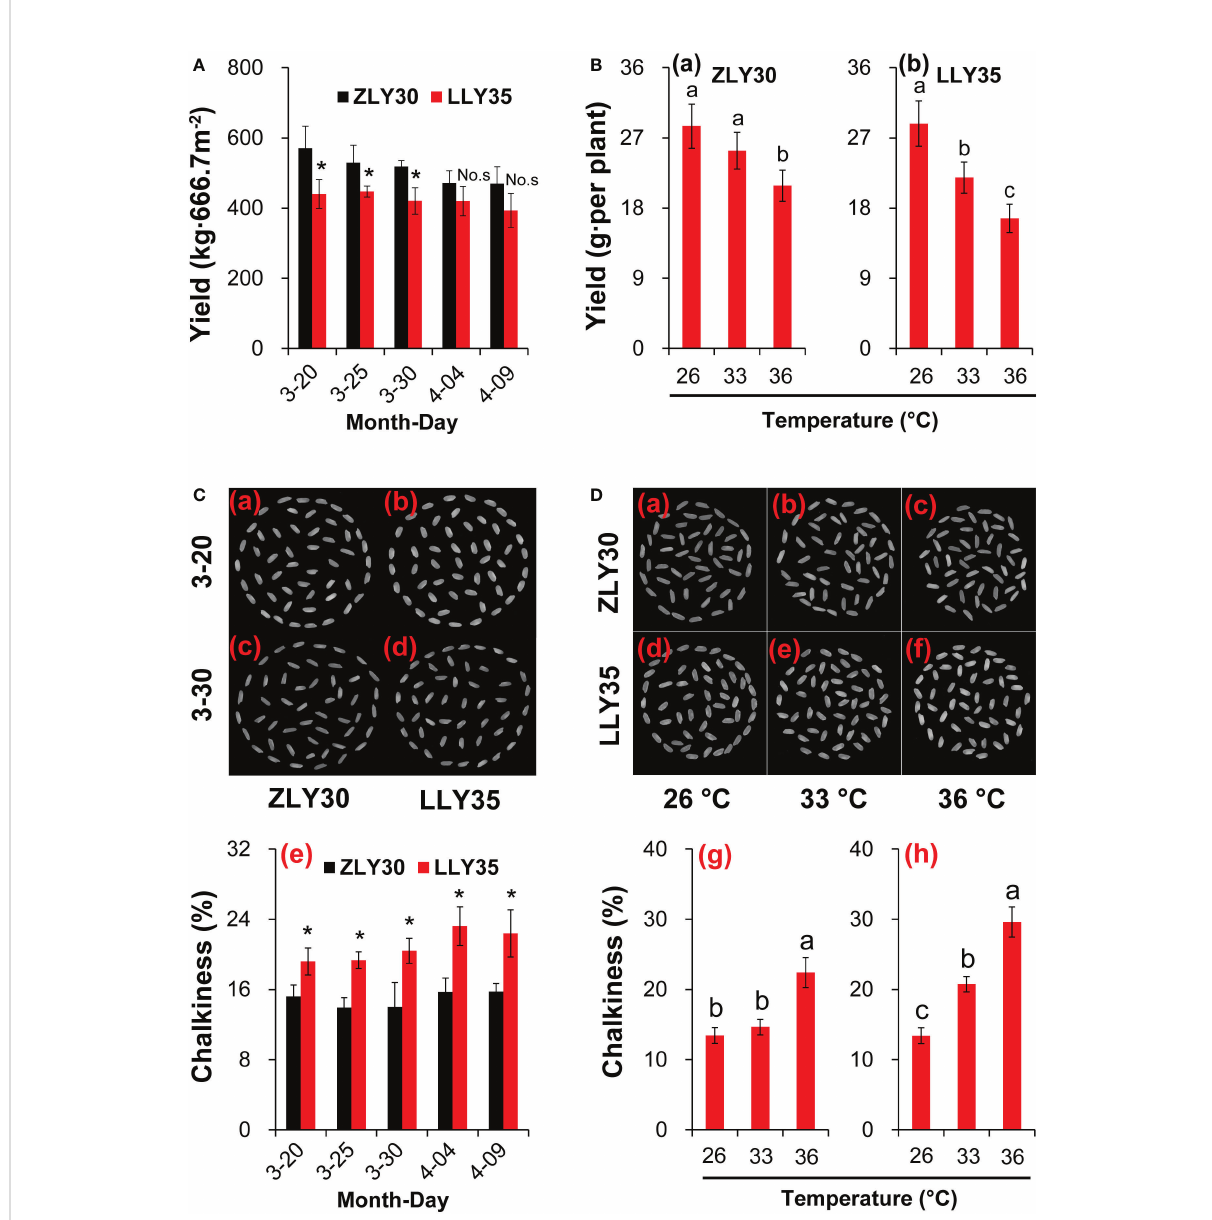
FIGURE 1 Effect of different sowing times and temperatures on yield and chalkiness degree in grains of rice. (A) Yields varied among the sowing times of ZLY30 and LLY35; (B) Changes in yields of two cultivars under different temperatures; (C) Chalkiness degree varied among the sowing times; (D) Changes in chalkiness degree of grains under different temperatures. Vertical bars denote standard deviations ( n =4). “ * ” indicated signi fi cant difference while “ No.s ” indicate no signi fi cant difference at the 0.05 probability level between the ZLY30 and LLY35 within one sowing time using T-test analysis. Different letters indicate signi fi cant differences with a least signi fi cant difference test at P ≤ 0.05 among different temperatures within one genotype using one-way analysis of